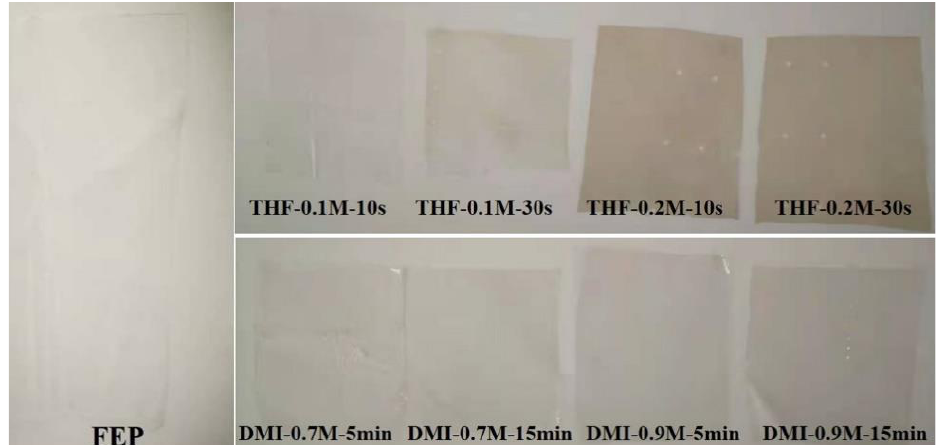
Figure 3. Photographs of the FEP films activated by sodium naphthalene solution.